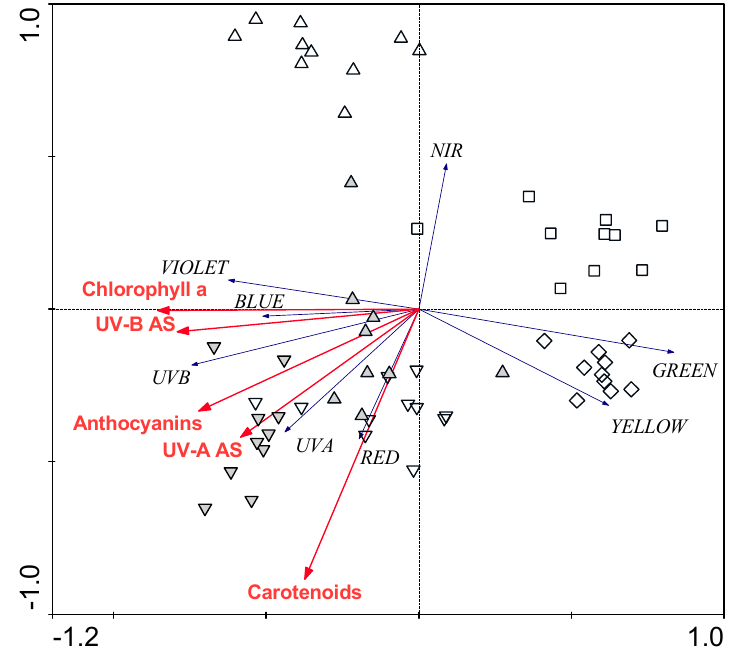
Figure 3. Redundancy analysis ordination diagram showing the strengths of the associations between the leaf biochemical parameters (i.e., carotenoids, UVA- and UVB-absorbing substances, chlorophyll a and anthocyanins) and the regions of the reflectance spectra for the leaves of the vines and willows. White diamonds, E. lobata ; white squares, P. quinquefolia ; white upright triangles, S. fragilis ; gray upright triangles, S. fragilis shaded by P. quinquefolia ; white upside-down triangles, S. caprea ; gray upside-down triangles, S. caprea shaded by E. lobata . Only the significant leaf parameters are shown.